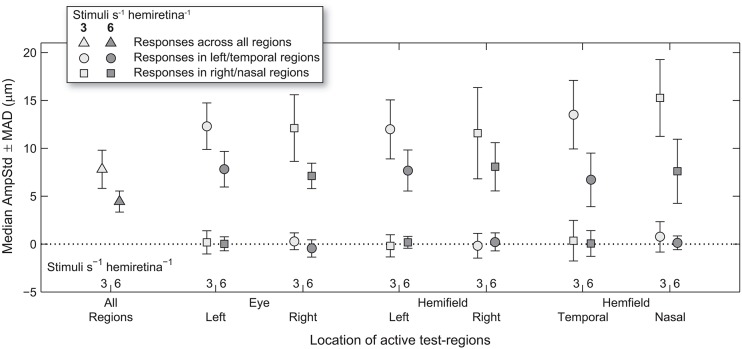
Median and median-absolute-deviation (MAD) of standardized constriction amplitudes (AmpStd) for the active and inactive subsets of test-regions in each stimulus variant across pupils, eyes (where relevant), and test-regions of all subjects.